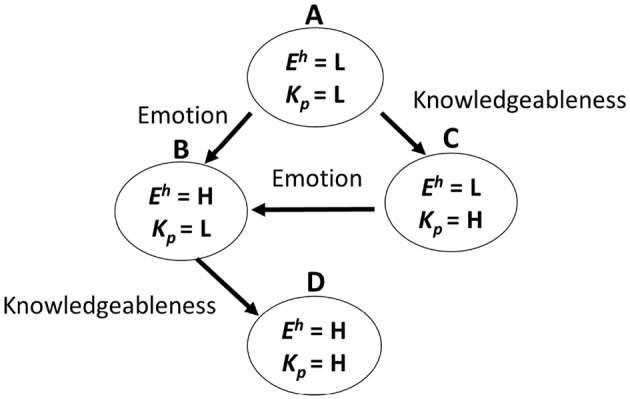
Observed transitions and effects of operators.